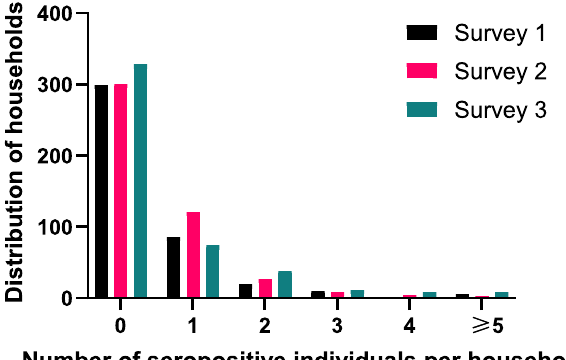
Figure 3. Distribution of households and number of individuals who were seropositive for both Spike and NC.